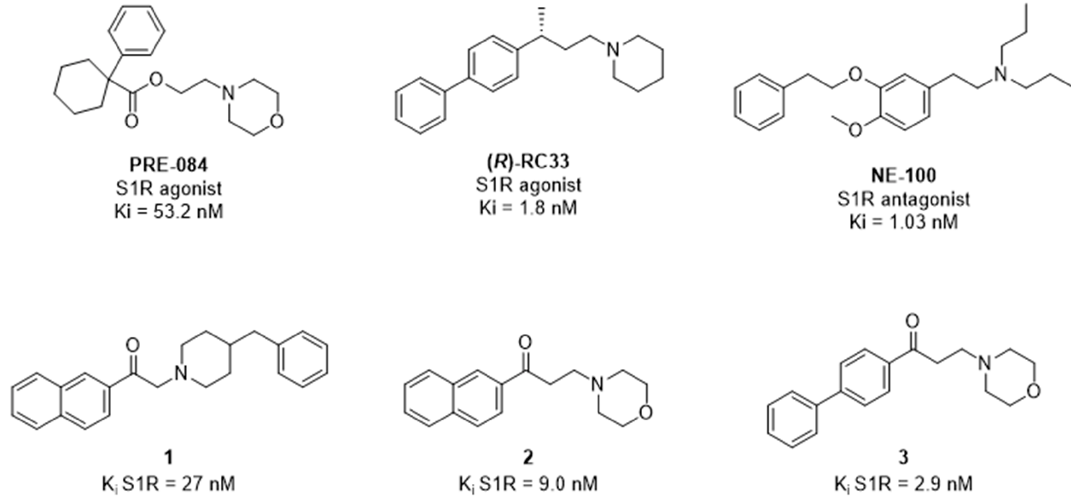
Figure 1. Chemical structures of S1R ligands tested in this study to evaluate their AQPs-mediated antioxidant effect.